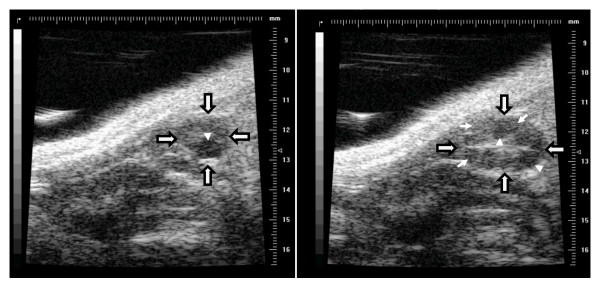
Images of ovarian follicles and corpora lutea in mice using ultrasound biomicroscopy. Arrows with a black outline define the external boundary of the ovary, white arrows point to corpora lutea, and arrow-heads indicate follicles. Numbers on the scale to the right of each image are in millimetres, with 0.1 mm increments.